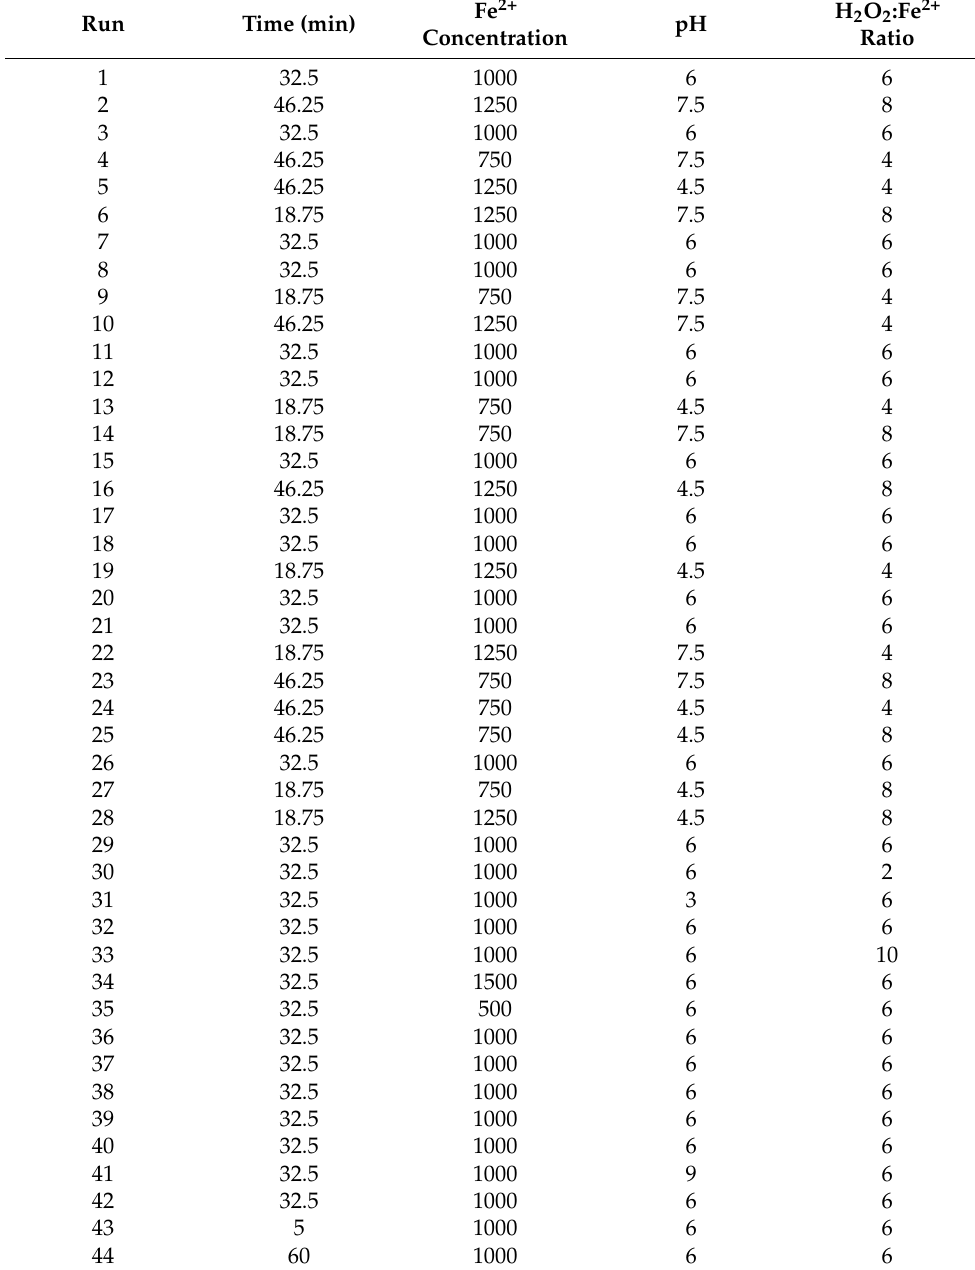
Table 3. Central composite experiments design.